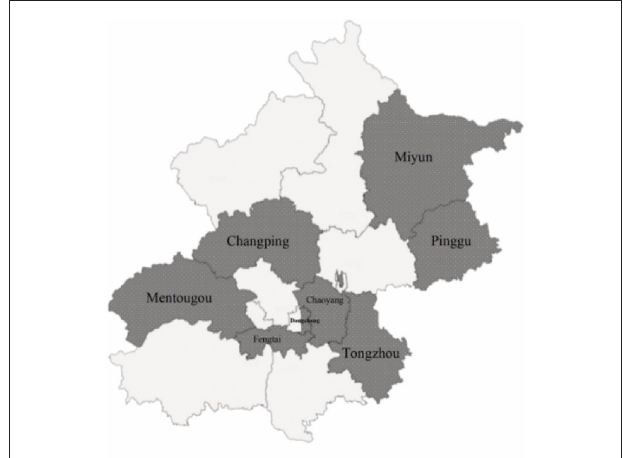
FIGURE 1 | Districts sampling